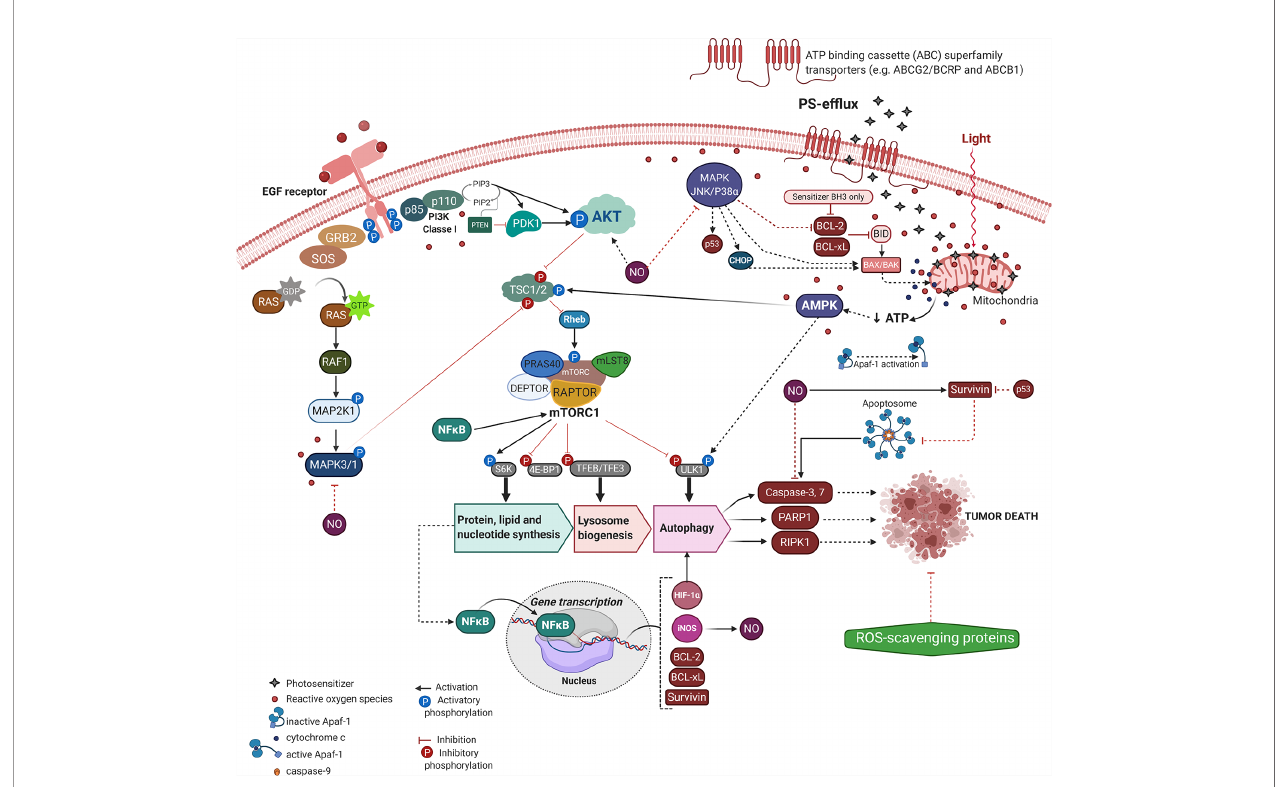
FIGURE 2 | Molecular mechanisms underlying PDT-resistance of tumor cells. Created with